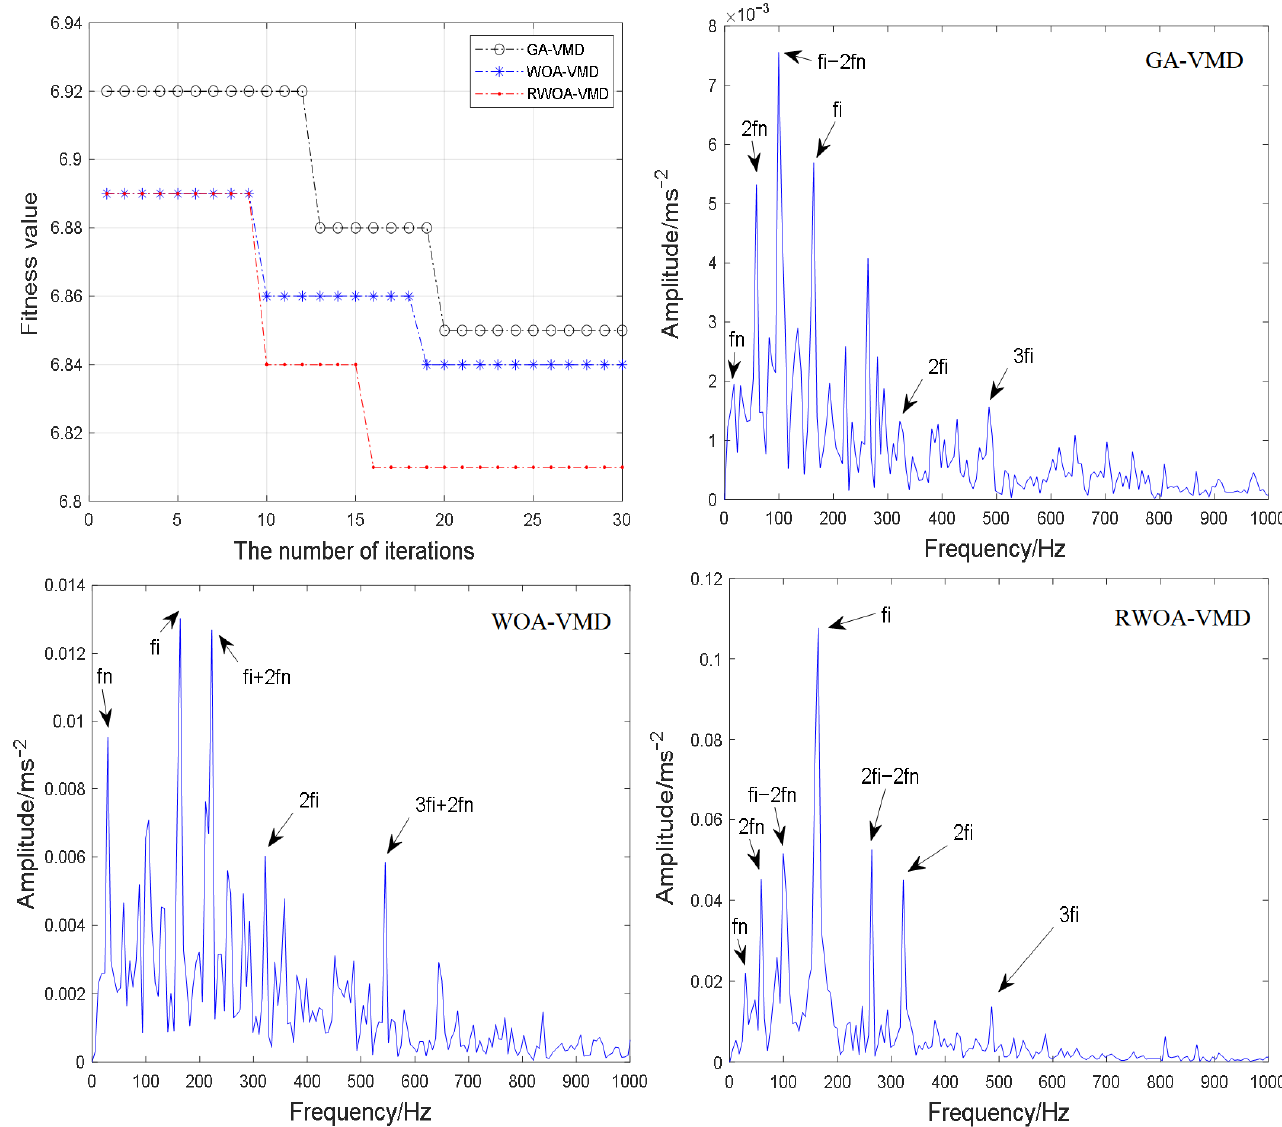
Figure 4. Comparison of processing effect based on GA ‐ VMD, WOA ‐ VMD and RWOA ‐ VMDA.